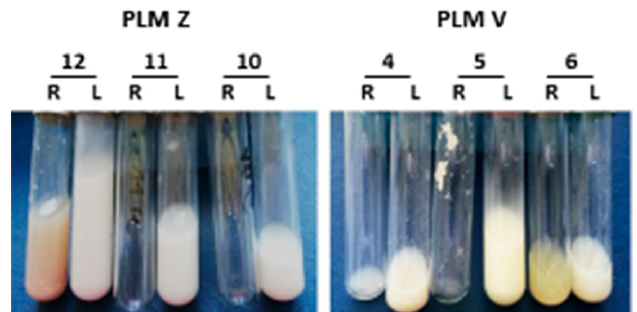
Figure 2. Altered or complete absence of milk from the right udder halves. A representative picture of milk secretions obtained on Day 17 p.i. (PLMZ) and Day 13 p.i. (PLMV), whereby left udder (L) milk samples appear normal but the yield from right udders (R) is either absent (sheep 10 and 11), severely reduced (sheep 4) or is abnormal and discolored, varying from watery yellow (sheep 6), to flaky (sheep 5) to reddish due to the presence of red blood cells (sheep 12).